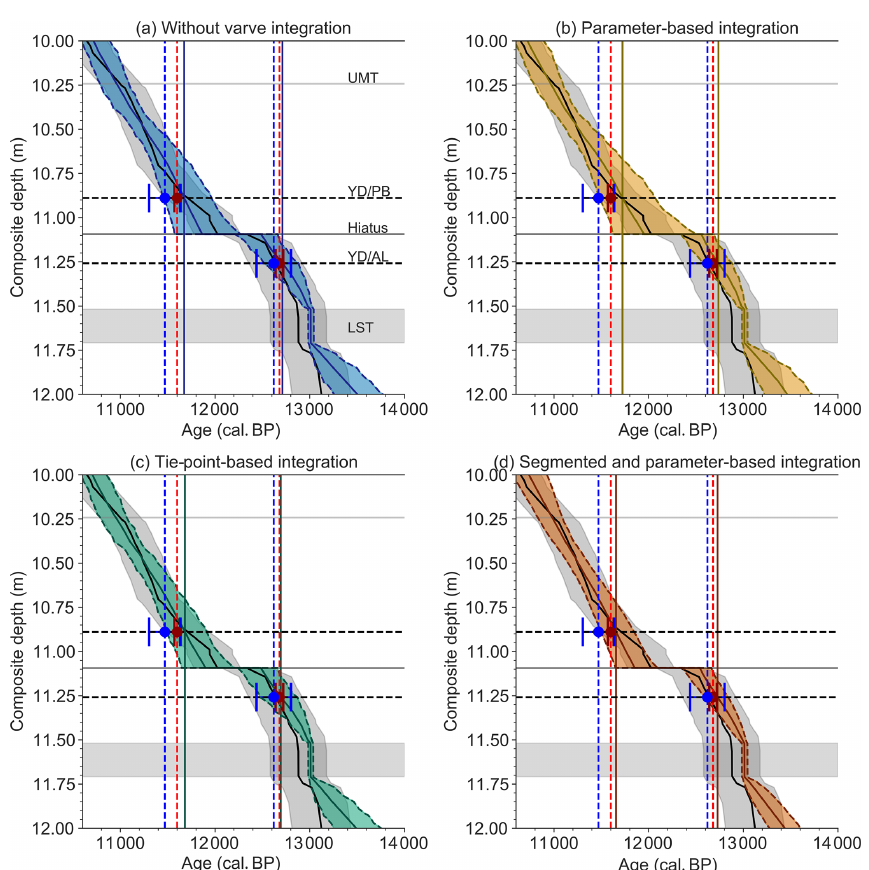
Figure A5. Close-up plots for the Late Glacial to early Holocene transition for Models A (a) , B (b) , C (c) , and D (d) with VT-99 mean age (solid black line) and error (shaded in grey) for comparison. Horizontal lines in all panels correspond to the labels in (a) . Vertical lines refer to the Younger Dryas transitions for each model (solid lines), while dotted lines refer to mean ages derived by different sites (Lake Gosciaz in blue from Bonk et al., 2021; Meerfelder Maar in red from Brauer et al.,